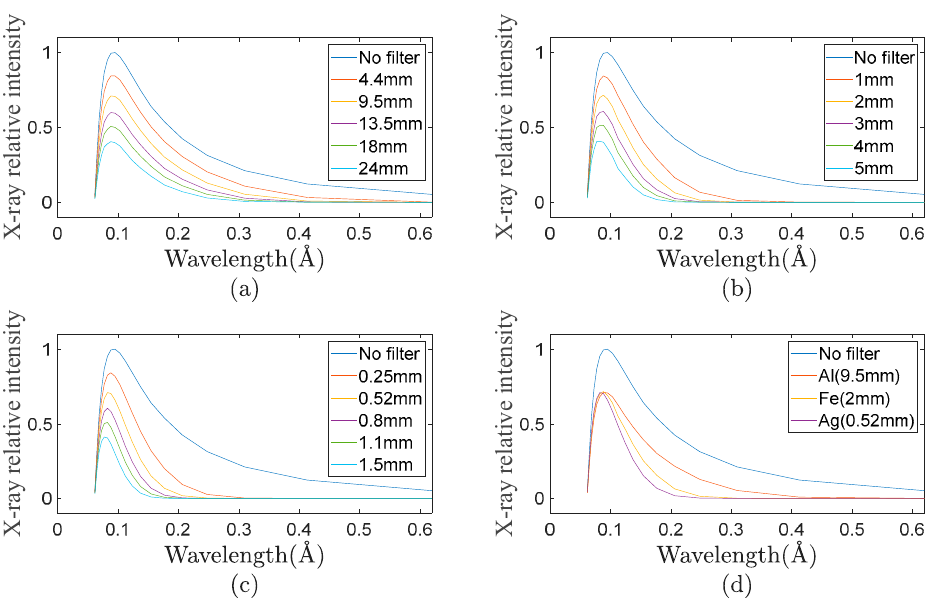
Figure 2. Influence curve of filter on X-ray spectrum. ( a ) Aluminum filter; ( b ) iron filter; ( c ) silver filter; and ( d ) comparison of filtering characteristics of three filters.